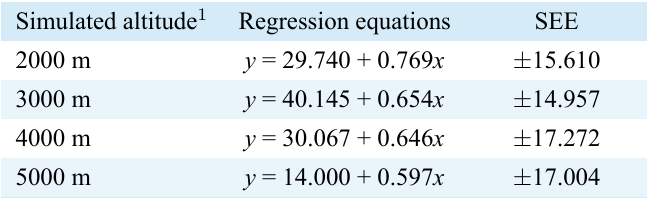
TABLE 12. Regression